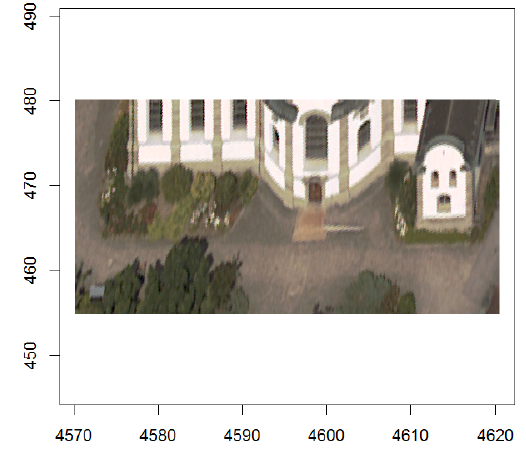
Figure 4. Plot of the point cloud with photo texture in the façade coordinate system (yZ). The measures are in